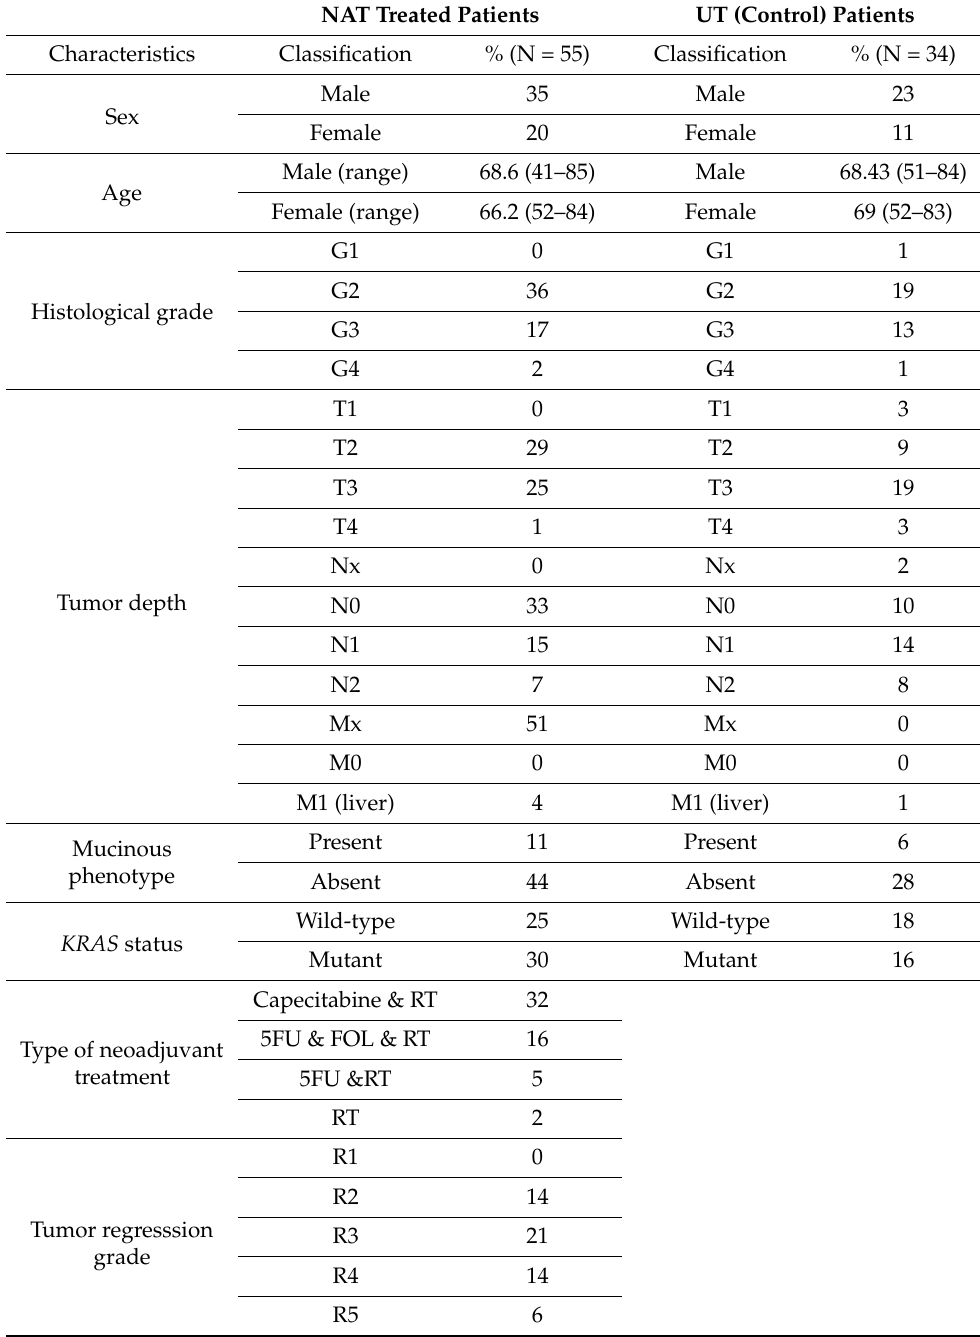
Table 3. Clinico-pathological and biological characteristics of rectal adenocarcinomas treated with neo-adjuvant therapy (NAT) and untreated controls (UT) evaluated in the